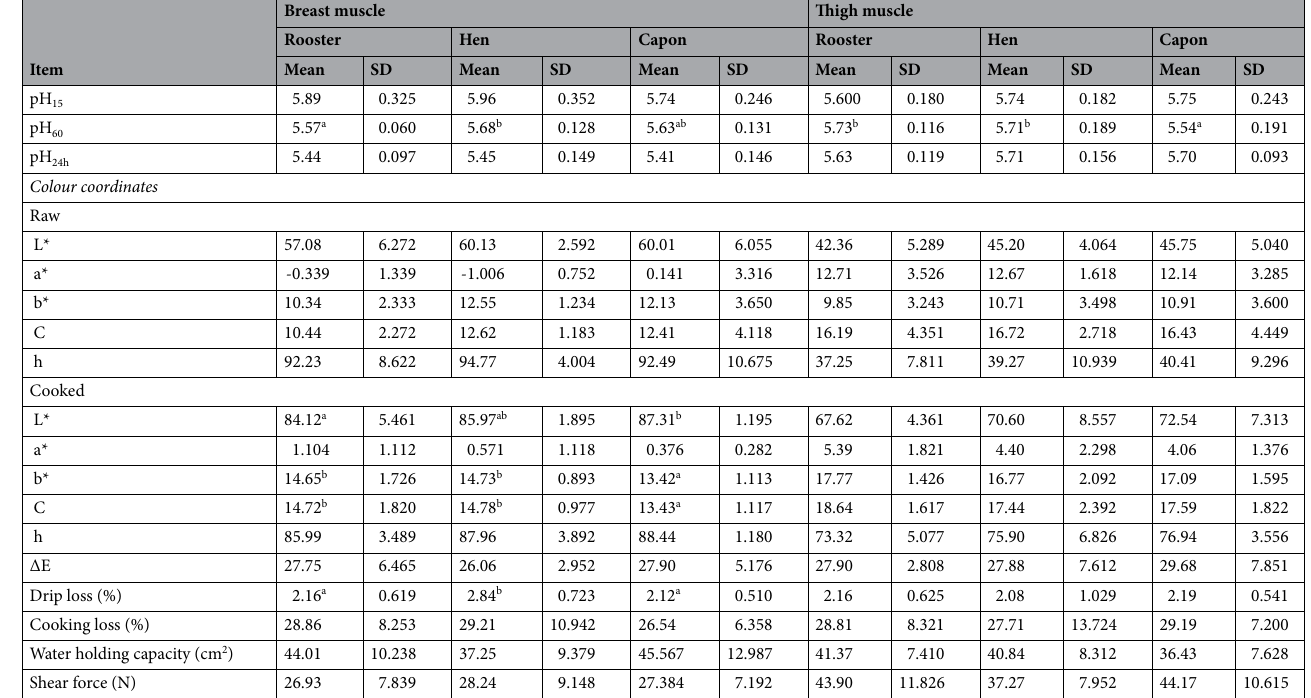
Table 1. Technological characteristic of muscles. ΔE The change of meat colour coordinates after thermal processing, a,b Mean values in the row (among particular muscle) differ significantly at p ≤ 0.05; SD standard